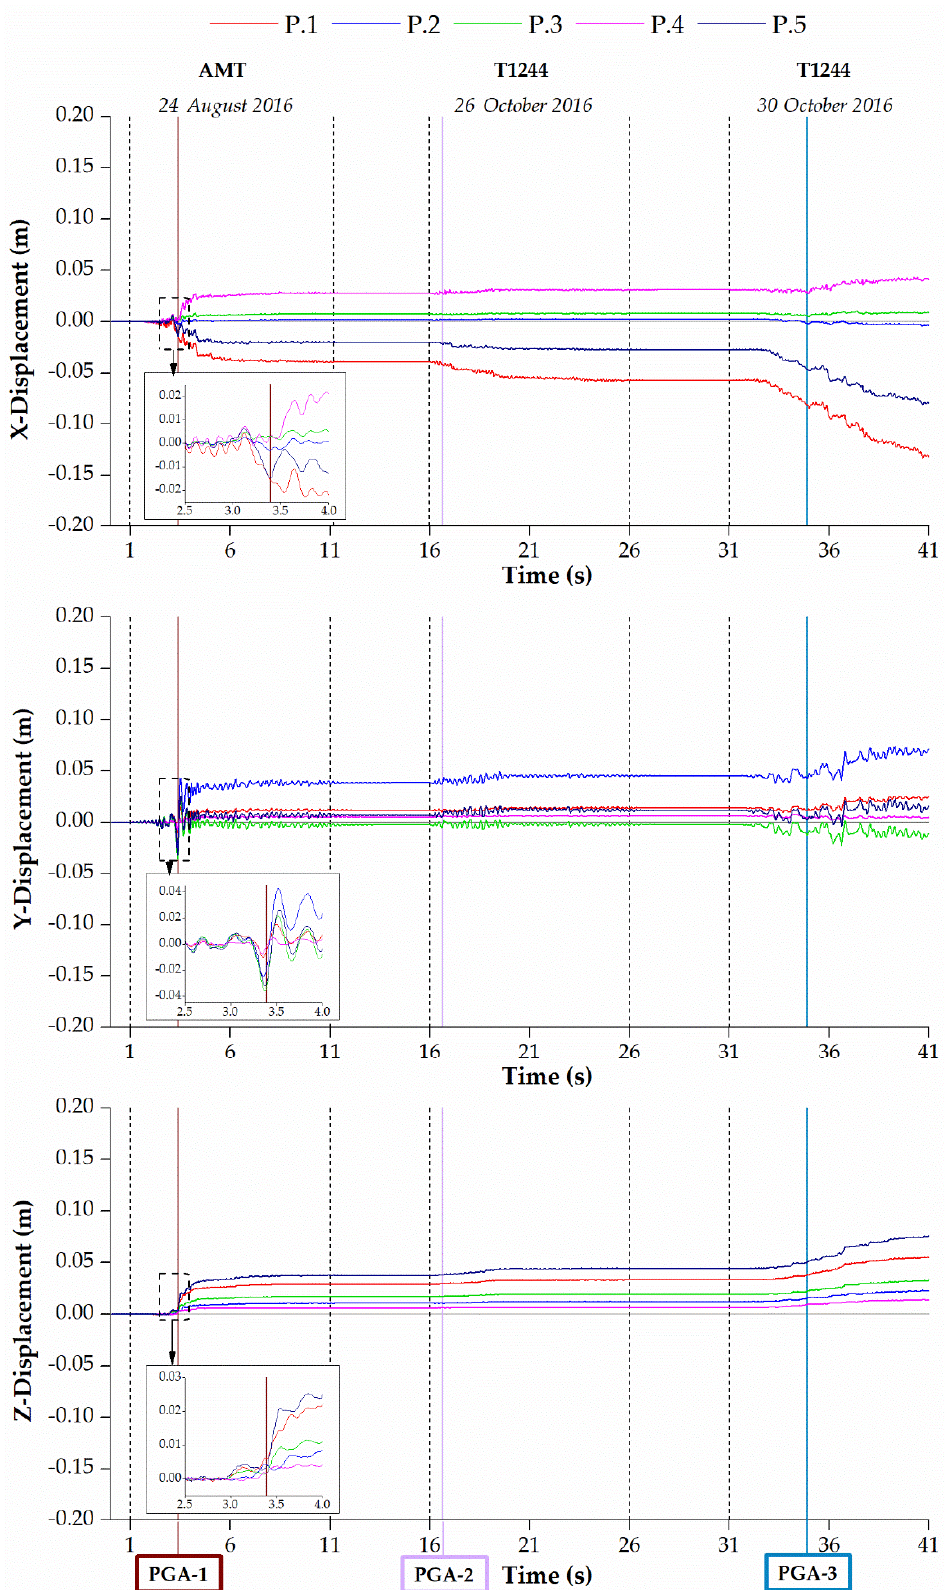
Figure 10. Displacements THs in the x, y, and z directions of the five church monitoring points calculated with nonlinear dynamic analyses by means of the CDP model under the seismic actions near the church.